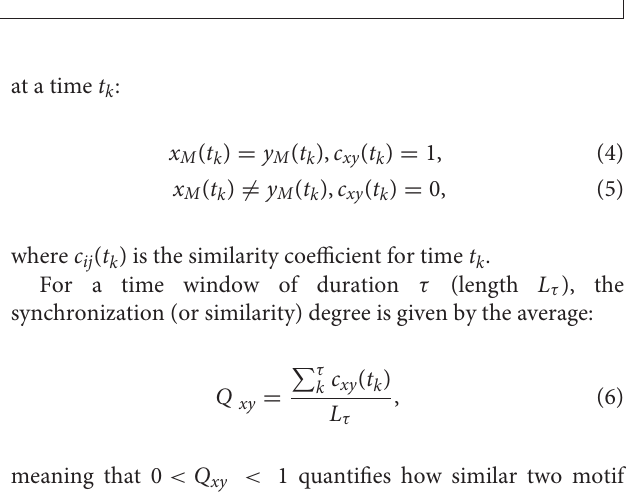
FIGURE 1 | Example of 1-s EEG epochs (63 channels). Upper image, epoch far from spikes (or IEDs); middle image, 1s before a spike; lower image, during spike activity (mid-spike).